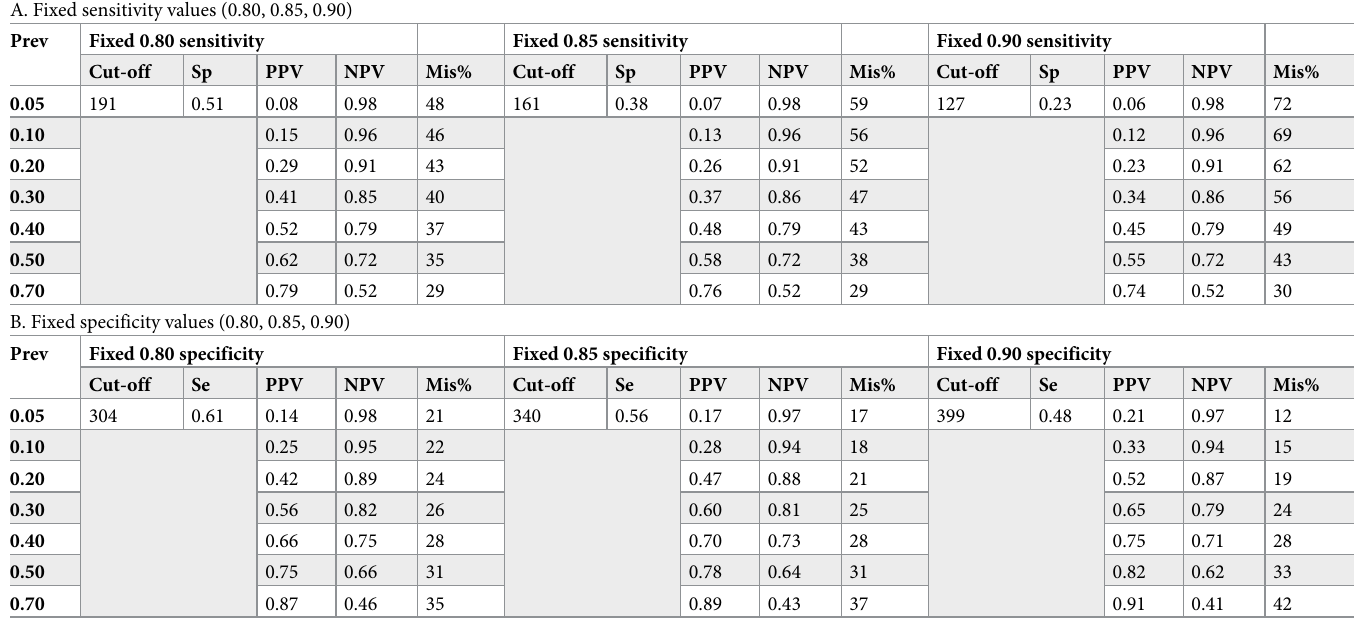
Table 2. Performance of M30 in detecting NASH: Positive and negative predictive values for different settings of NASH prevalence. A. Fixed sensitivity values (0.80, 0.85, 0.90) Fixed 0.80 sensitivity